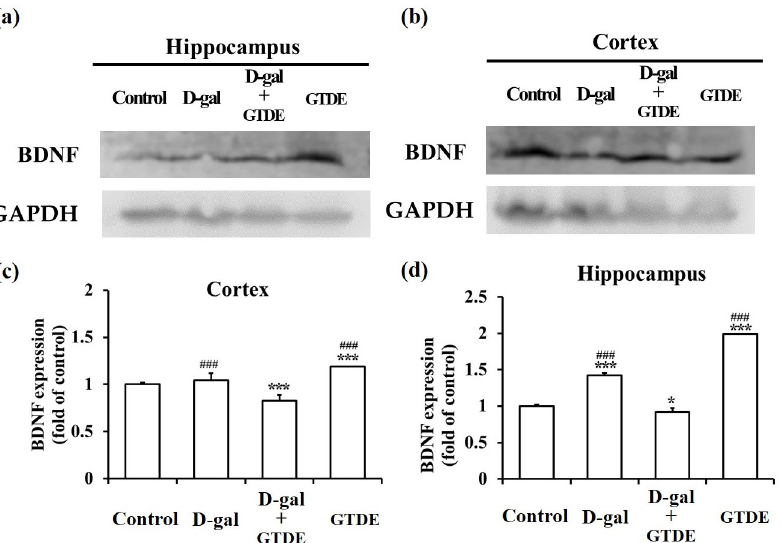
Fig 5. The application of GTDE efficiently increased the D-gal induced decline in the expression levels of BDNE. (a) to (d) Western blots of the proteins obtained from the homogenization of the hippocampal and cerebral cortical tissues of the rats. The change in BDNF was compared with the use of GAPDH as the loading control. (a) and (b) Representative western blots for the hippocampus and cerebral cortex, respectively. (c) and (d) Corresponding quantified results. Intergroup differences were compared using one-way ANOVA followed by the Tukey’s multiple comparisons test. Statistically significant differences based on comparisons with the control group are denoted by � P < 0.05, �� P < 0.01, ��� P < 0.001; statistically significant differences based on comparisons with the D-gal group are denoted by # P < 0.05, ## P < 0.01, ### P < 0.001. n =